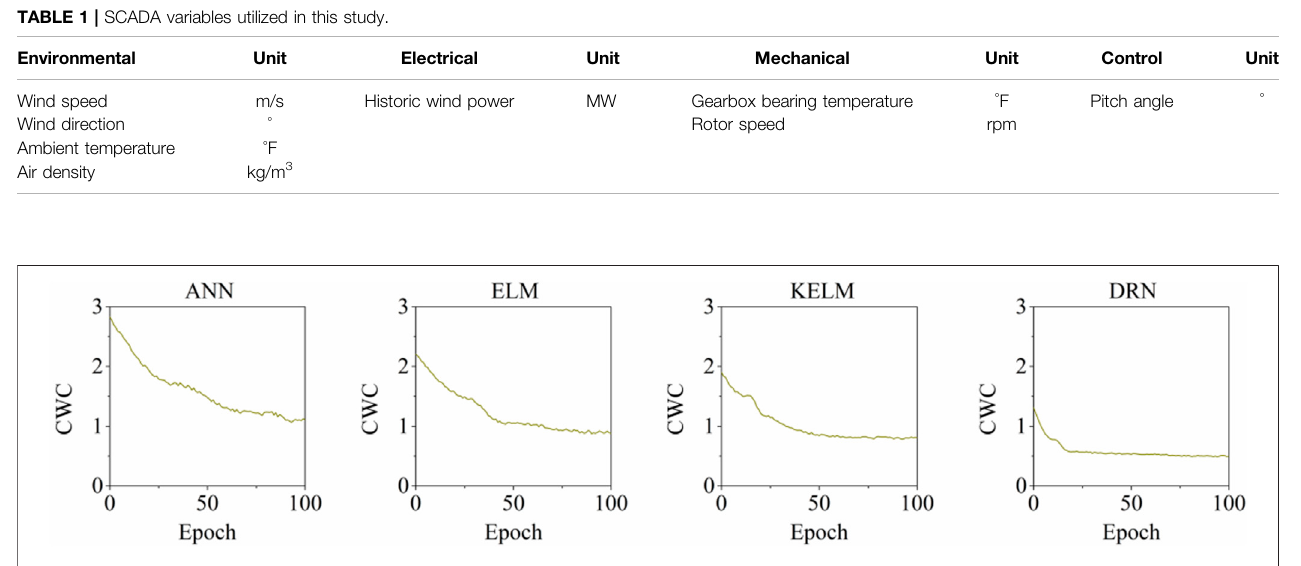
FIGURE 2 | Changes of CWC at different training epochs.